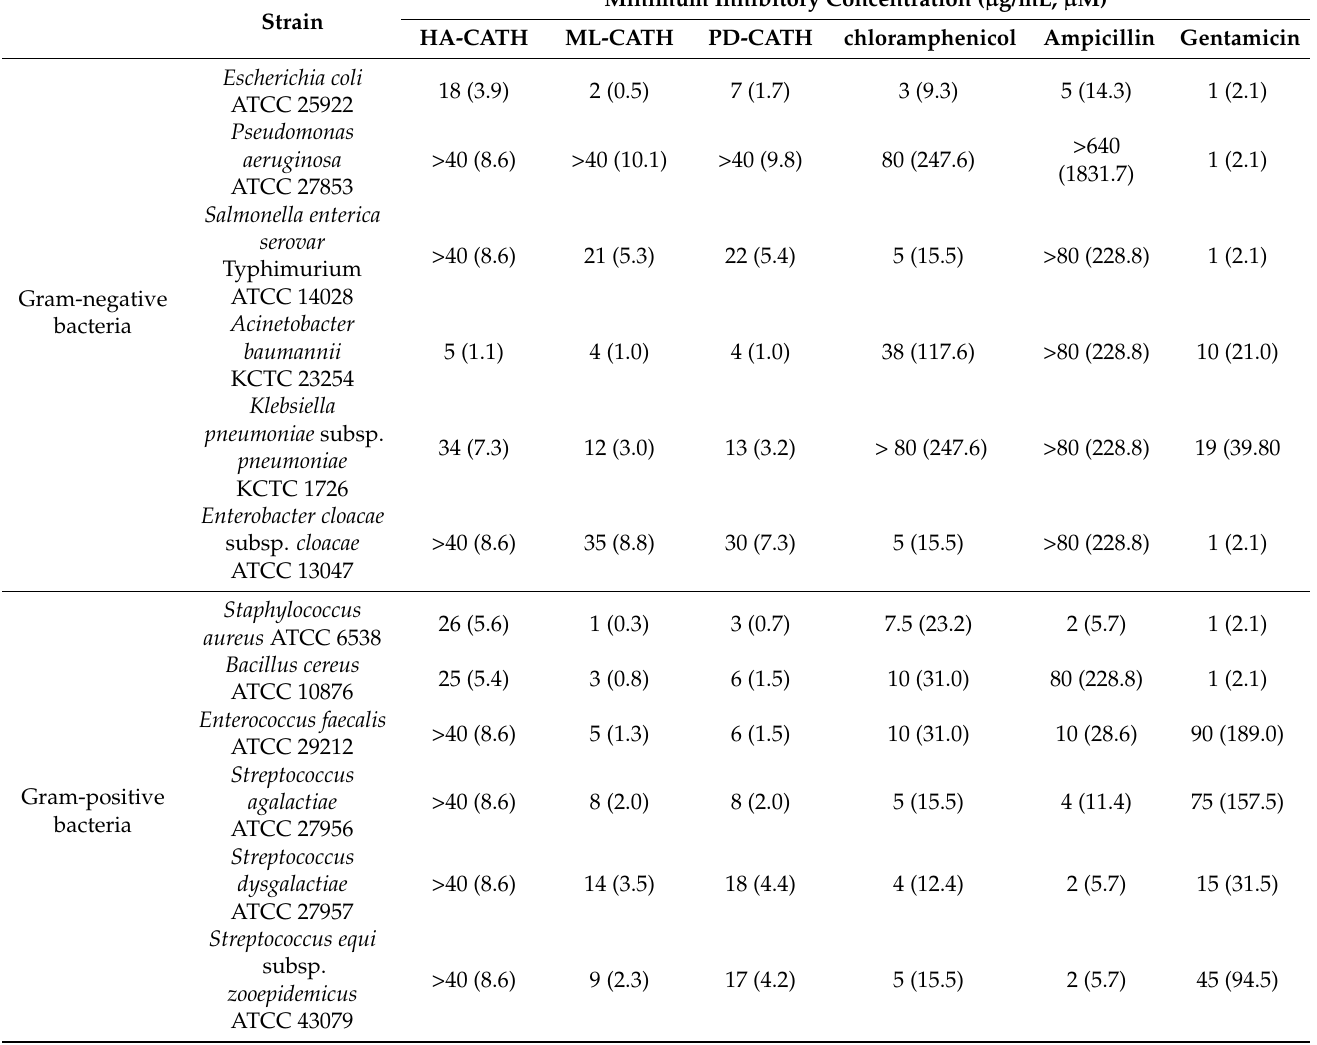
Table 2. Minimum inhibitory concentrations of three bat cathelicidin-derived peptides against various bacterial strains.